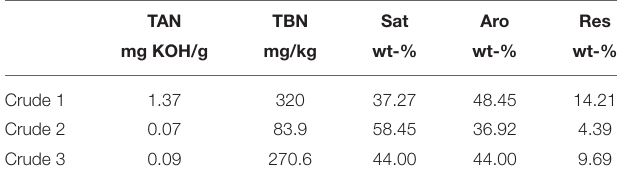
TABLE 1 | Fluid properties in pore-scale and Darcy-scale SCAL experiments. TABLE 2 | Analysis of the 3 crude oils in terms of total acid number (TAN), total basic nitrogen (TBN), and the SARA analysis in terms of saturates (Sat), aromats (Aro), and resins